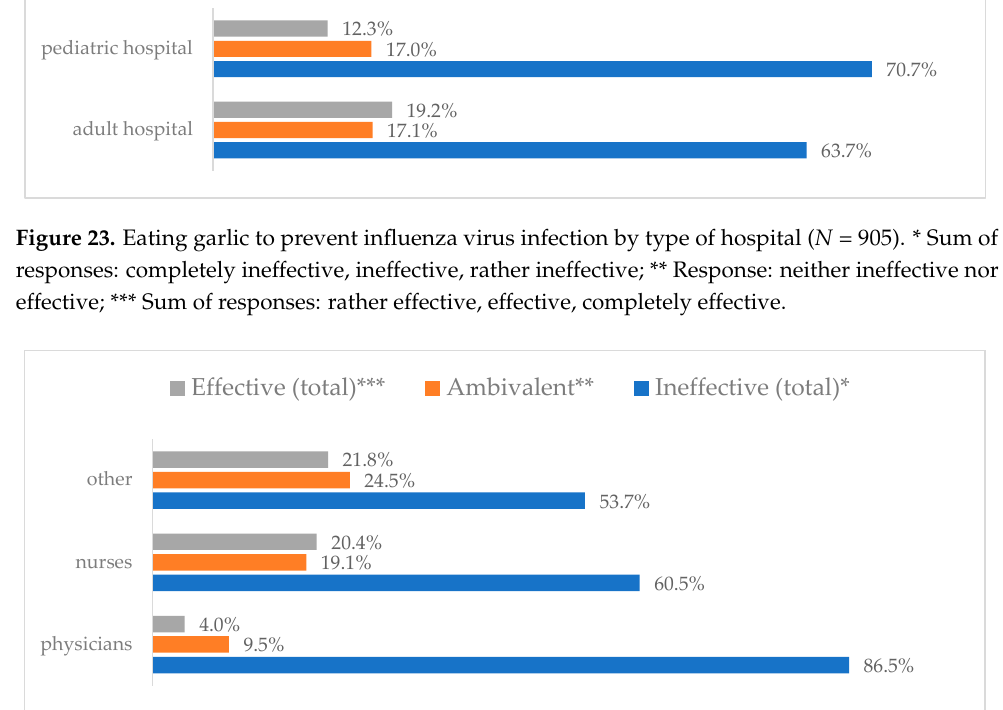
Figure 24. Eating garlic to prevent influenza virus infection by profession ( N = 905). *Sum of responses: completely ineffective, ineffective, rather ineffective; **Response: neither ineffective nor effective; ***Sum of responses: rather effective, effective, completely effective.